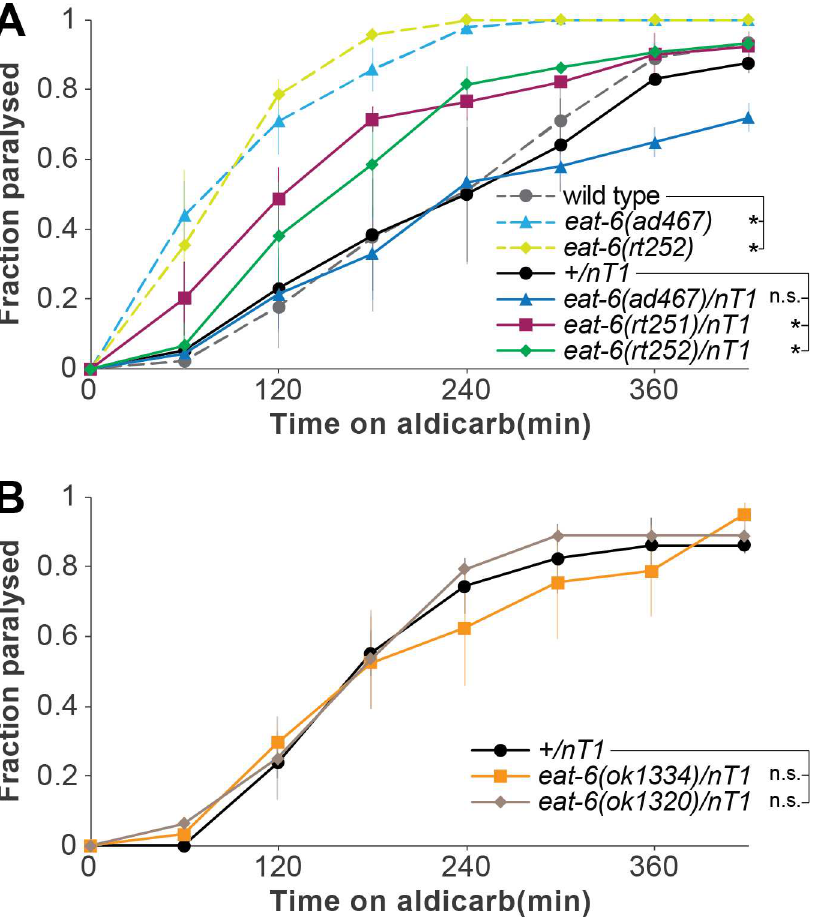
Fig 2. EAT-6 G304S has a dominant negative effect. (A) Animalsheterozygous for the G304S mutation were hypersensitive to 1mM aldicarb, whereasthe reference ad467 allelewas recessive (3 trials ± SEM, * : log-rankp-value < 0.05). (B) Animalswith heterozygous eat-6 completeloss of function allelesdid not exhibit neuromuscular defects (2 trials ± SEM; n.s.:not significant,p-value > 0.05).